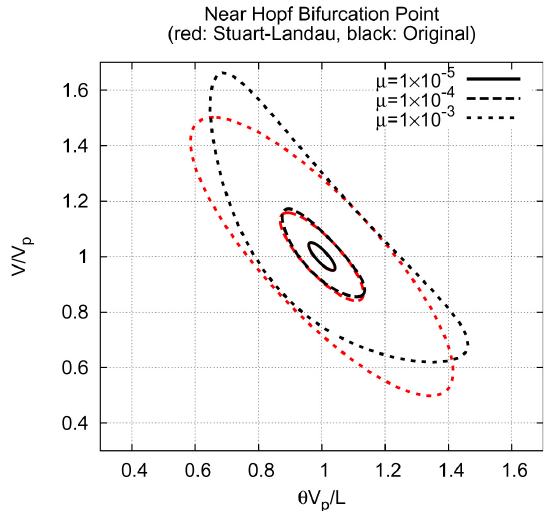
Fig. 2. Periodic orbits of the Dieterich–Ruina oscillator near the bi- furcation point, graphs of (cid:0) θV p /L,V/V p (cid:1) . Red and black curves are for the periodic solutions of the Stuart–Landau and original differ- ential equations, respectively. The equilibrium point is ( 1 , 1 ) . The values of bifurcation parameter µ are set to 1 × 10 − 5 Nm − 2 (solid curves), 1 × 10 − 4 Nm − 2 (dashed curves), and 1 × 10 − 3 Nm − 2 (dot- ted curves). The values of k used here are obtained by setting k = (B − A − gV p − µ)/L and using the corresponding values of µ . The rest of parameters are set to (V p ,g,A,B,L) = (3 . 17 × 10 − 9 ms − 1 , 5 . 00 × 10 6 Nm − 3 s, 1 . 50 × 10 5 Nm − 2 , 2 . 20 × 10 5 Nm − 2 , 1 . 00 × 10 − 2